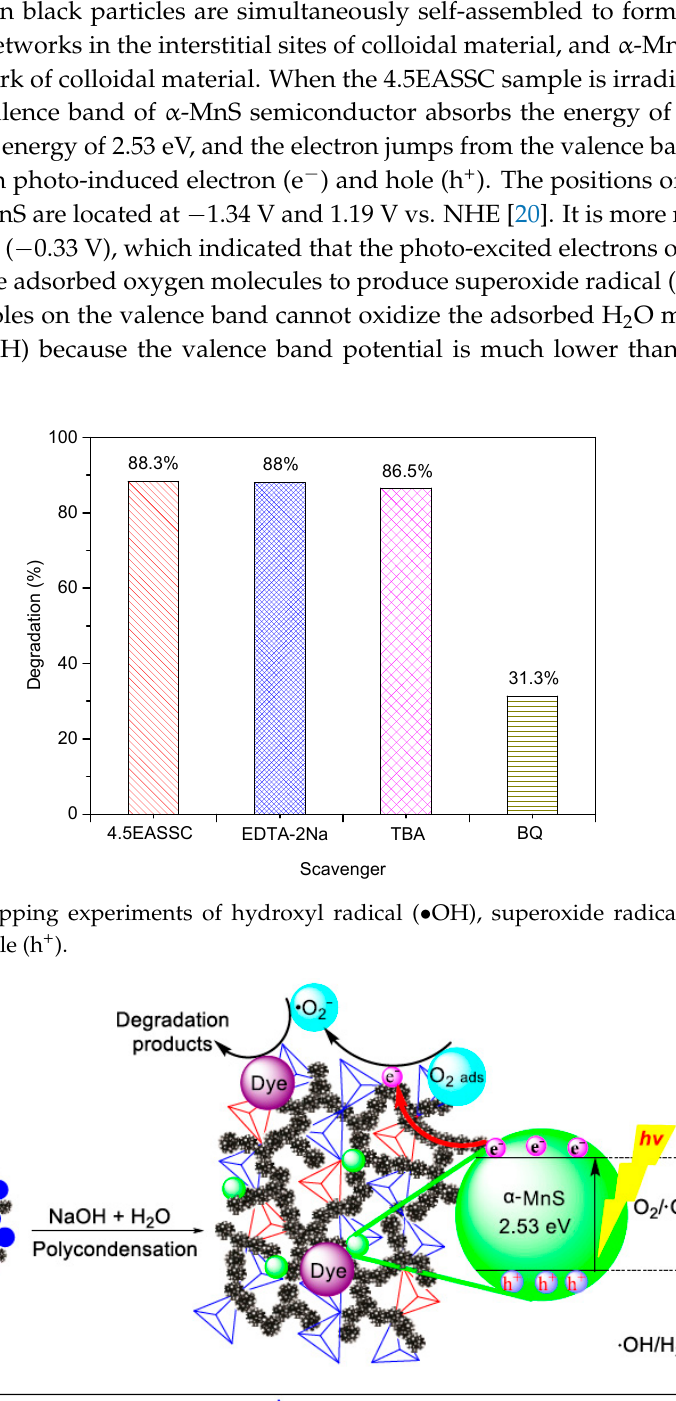
Figure 8. The schematic mechanism of the photocatalytic removal of dye pollutant on 4.5EASSC sample.